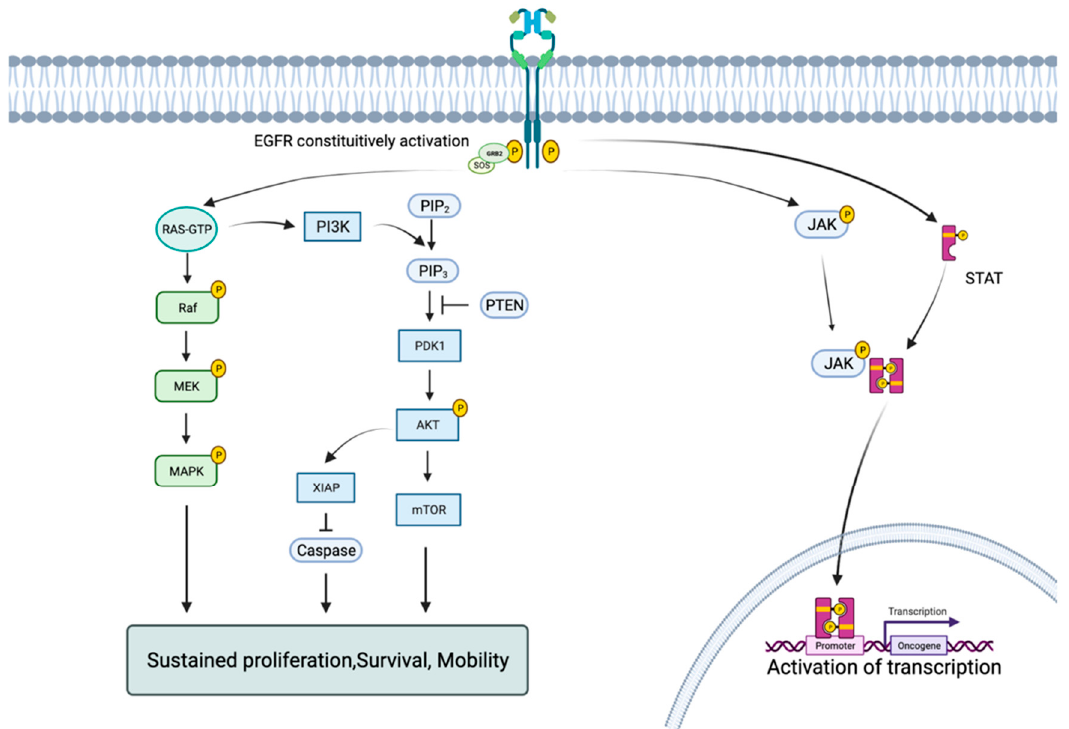
Figure 1. Summary of the EGFR-TKI signal transduction pathway.